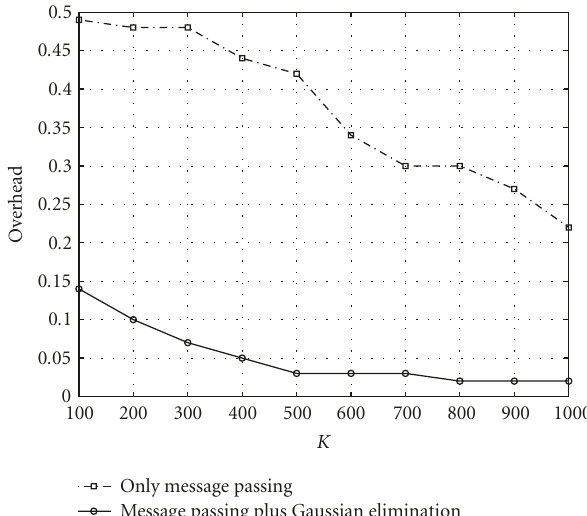
Figure 2: The overhead of Fountain codes (LT codes, c = 0.03, δ = 0 . 3). Fountain-encoded packets are transmitted over the erasure channel with the erasure probability of 20%. The dash-dot curve is the overhead of LT codes only using message-passing decoding and the solid curve is the overhead of LT codes using message-passing algorithm and Gaussian elimination together to